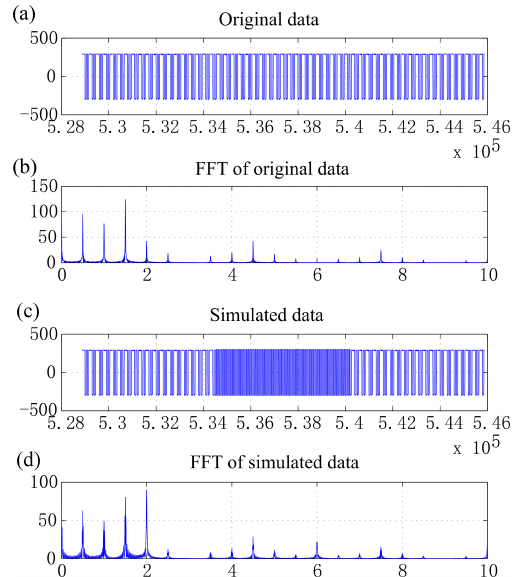
Figure 4. Original data (a, b) and simulated data of frequency vari- ation (c, d) .